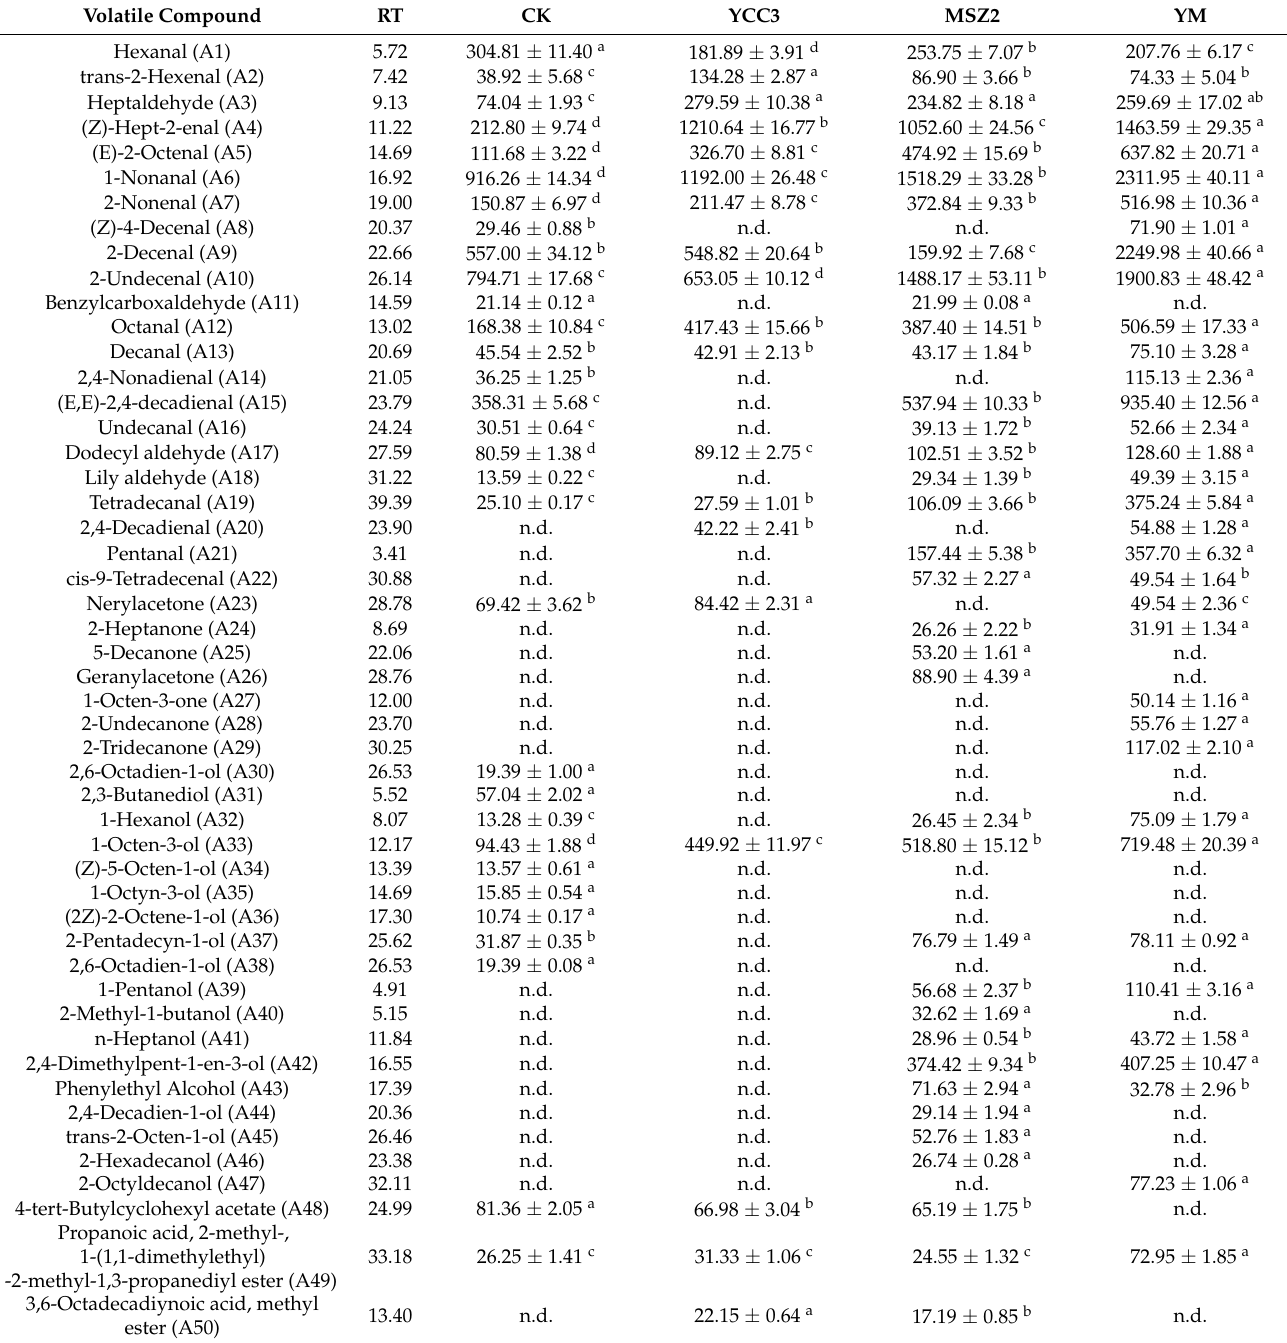
Table 4. Content of volatile flavor compound (ug/kg) in four fermented sausage